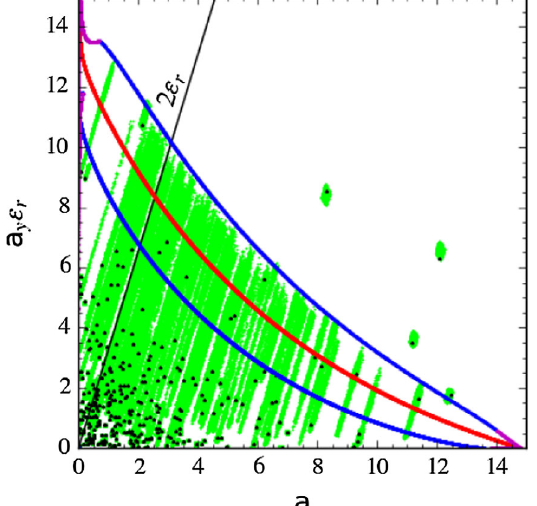
FIG. 6. Collection of all stationary points (red line) and outer and inner edges of the separatrix (blue line) in a high-intensity bunched beam. The green traces are the evolution of particles during